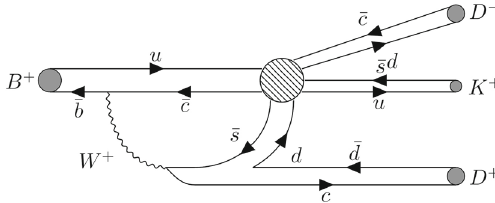
Fig. 3 Schematic diagram of process B + → D + D − K + . The shadow circle represents the production vertex of X 1 ( 2900 )